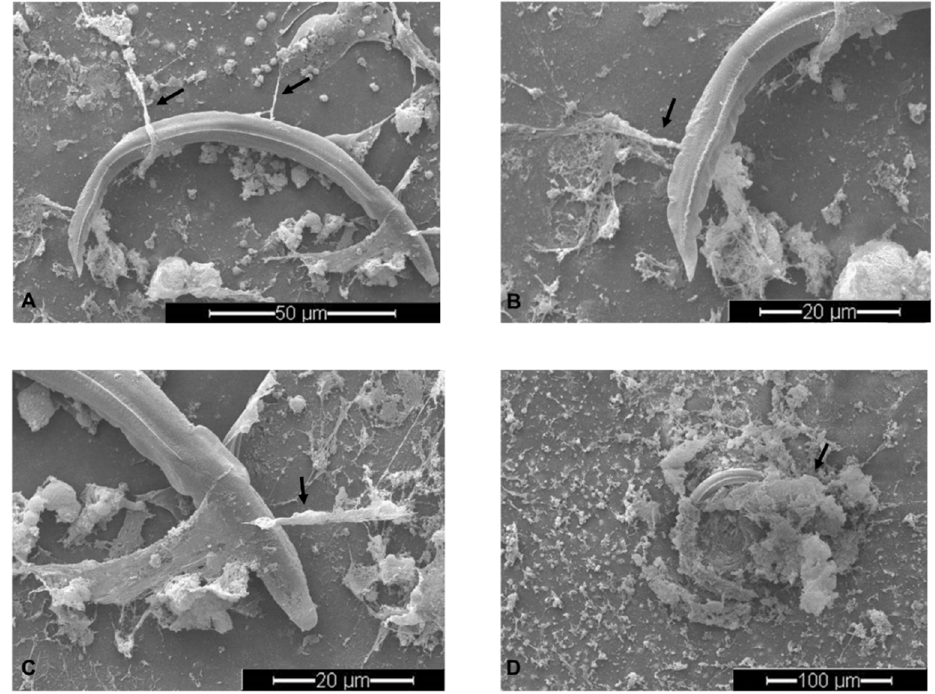
Figure 1. Angiostrongylus vasorum L3-induced neutrophil extracellular traps (NETs) analyzed via scanning electron microscopy (SEM) analysis. Fine spread NETs ( spr NETs) entrapping the L3 ( A – C ) and robust aggregated NETs ( agg NETs) ( D ) were the most predominant phenotypes of NETs. Arrows point to NET-like delicate PMN-derived structures in co-culture